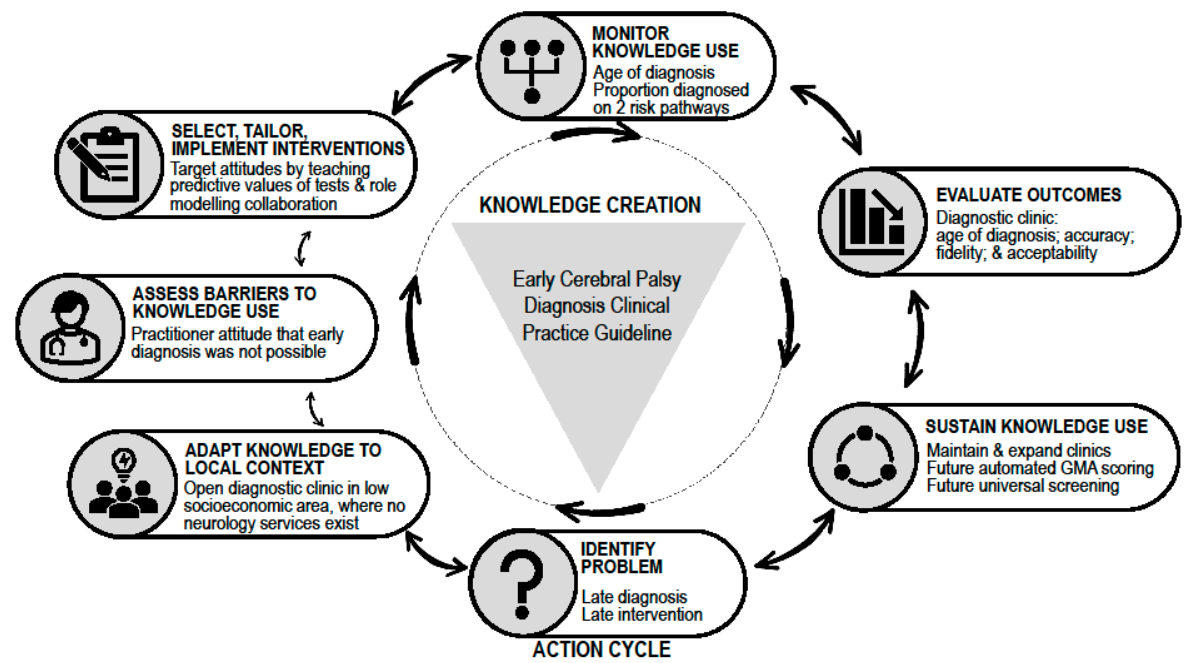
Figure 1. Knowledge translation strategy example using Knowledge-to-Action cycle [25]. Abbreviation: GMA, General Movements Assessment.